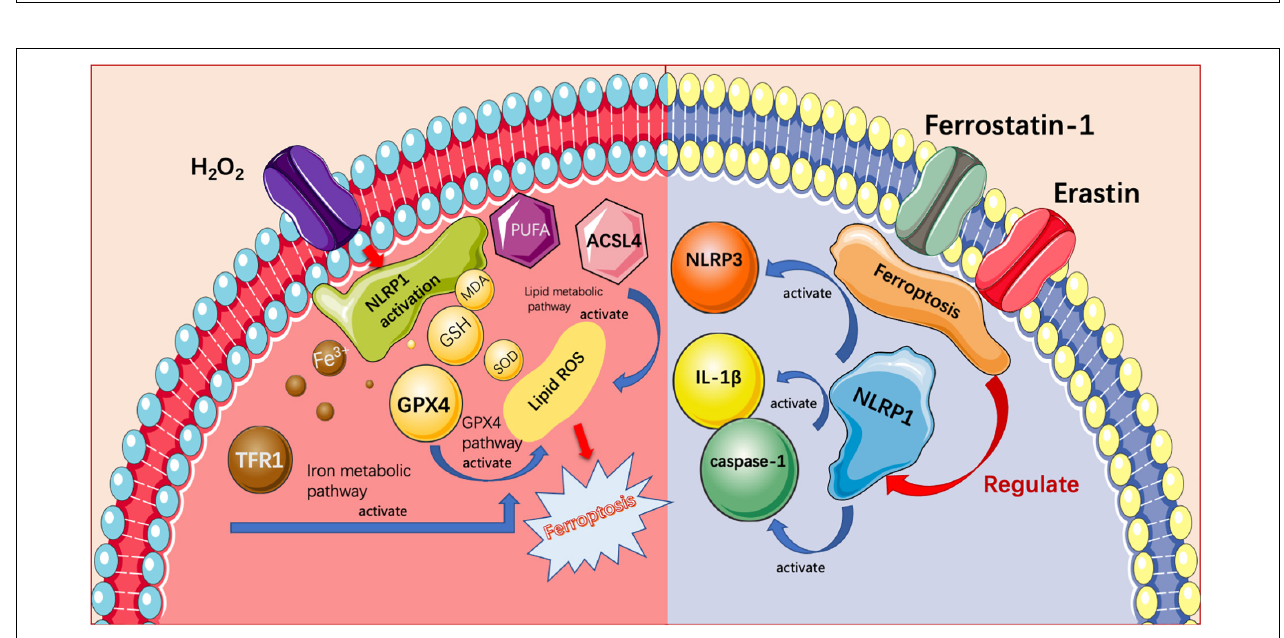
FIGURE 6 | NLRP1 causes ferroptosis in trophoblast cells through three pathways and ferrostatin-1 and erastin regulate the expression of NLRP1 inflammasome in trophoblast cells by affecting ferroptosis.